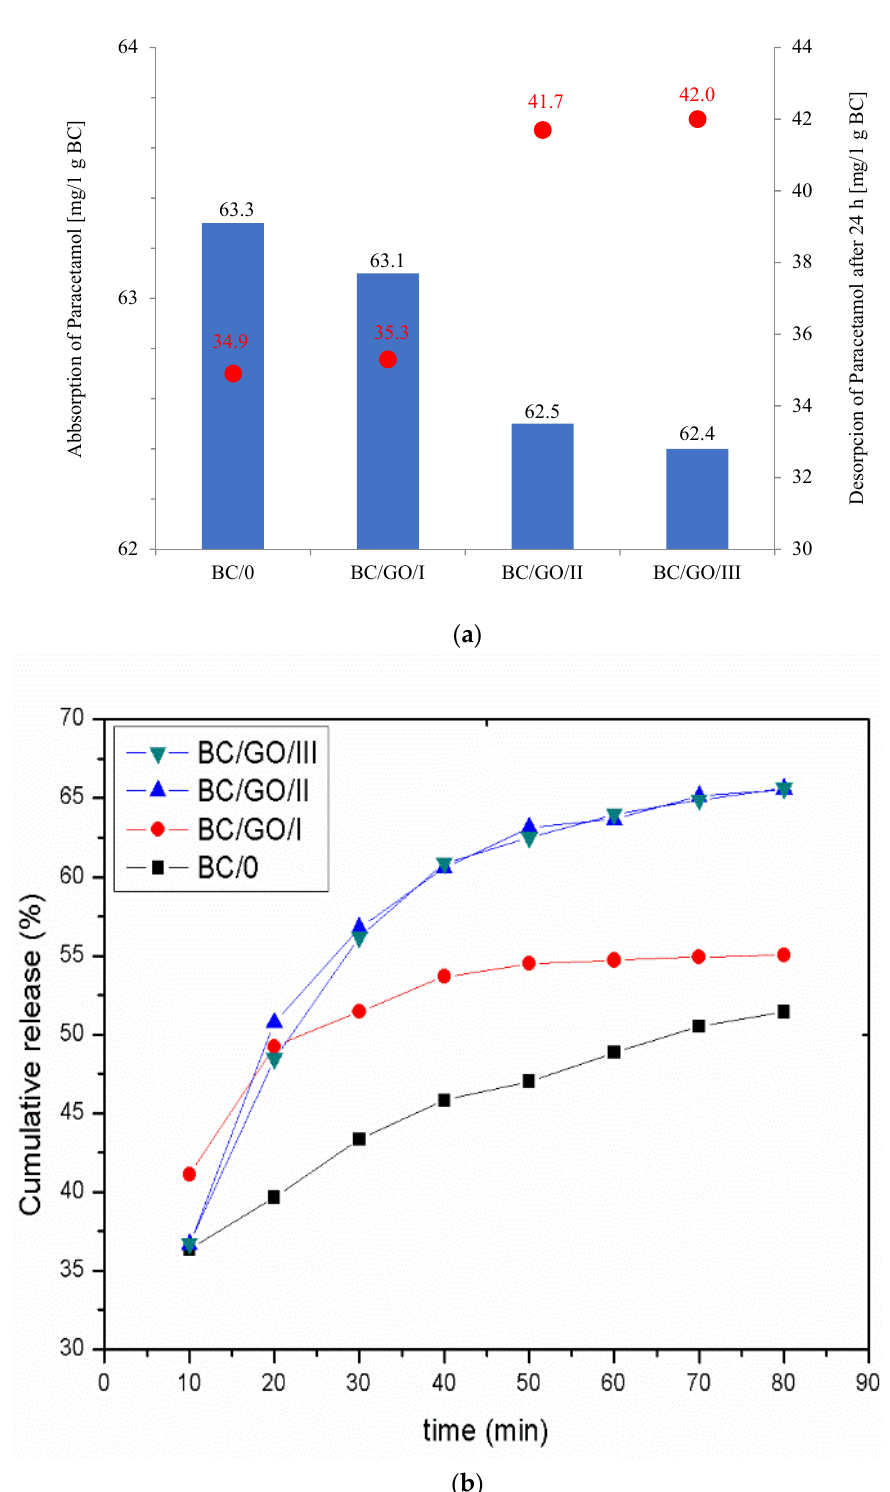
Figure 5. ( a ) Graph of active substance absorption on membranes and active substance desorption from membranes after 24 h; ( b ) Paracetamol release from pure cellulose (BC/0) and composite (BC/GO/I, BC/GO/II, BC/GO/III) membranes to PBS solution. Interesting results were obtained during the study of the kinetics of the medicine The use of FiberMetric software from PhenomWorld (v. 2.9.0, Eindhoven, The Netherlands) release from the tested membranes (Figure 5b). They show that the BC/0 sample desorbs for the analysis of SEM images of the membranes allowed performing thickness measurements, paracetamol slowly but steadily; however, the release rate is less than 55%. On the other which are summarized in Table hand, the membrane with the lowest GO content (3.7% w / w ) is characterized by a more